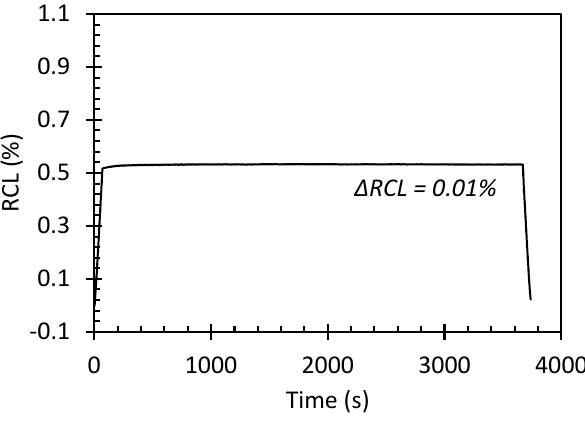
Figure 6. Relative change in length (RCL) as a function of time for 06CV steel tempered at 350 °C.